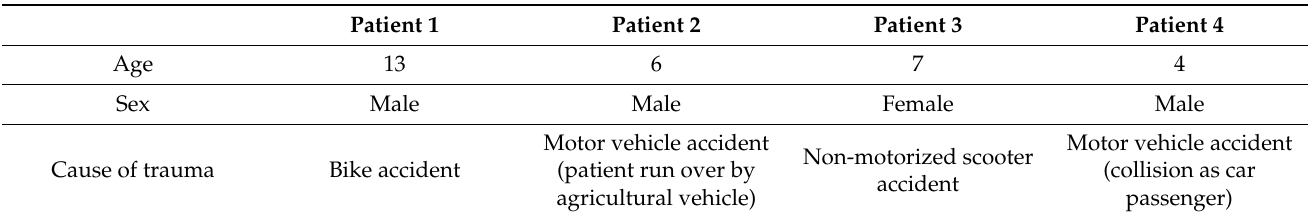
Figure 1. Complete rupture in the middle of the pancreas. Table 1. Patient characteristics and treatment timelines [11].